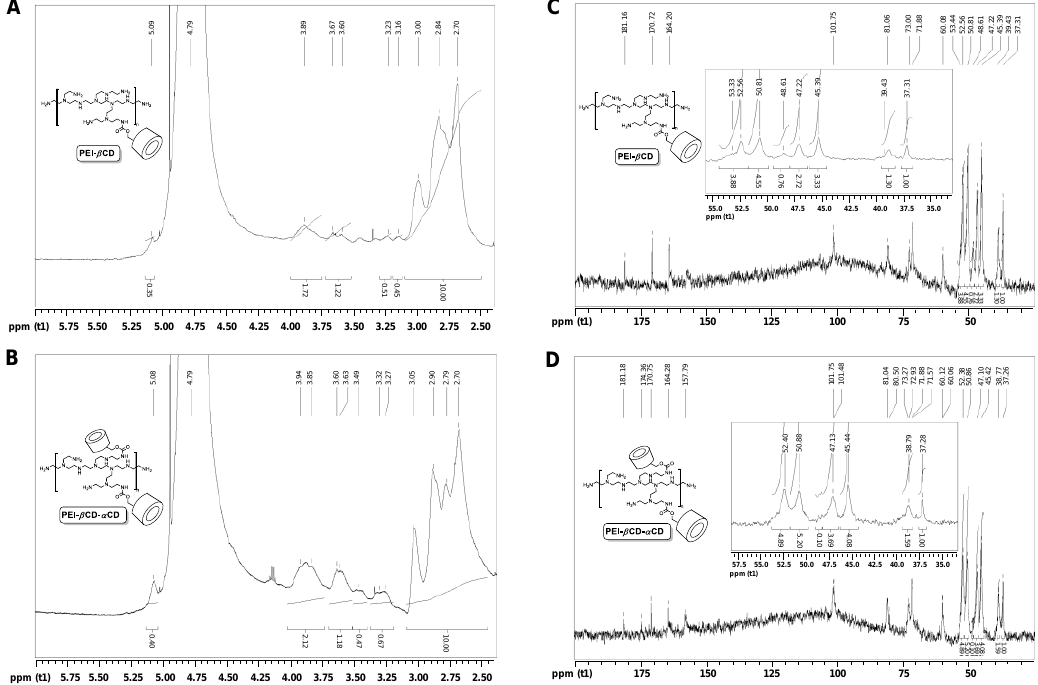
Figure 1. 1 H NMR spectrum (500 MHz, D 2 O) of PEI- β CD ( A ) and PEI- β CD- α CD ( B ). Inverse-gated 13 C H NMR spectrum (125 MHz, D 2 O) of PEI- β CD ( C ). The ratio of PEI’s amino groups (NH 2 :NH:N) is 1.00:1.48:1.22, which stands for 6% of functionalization of primary amino groups of PEI with β CD. Inverse-gated 13 C H NMR spectrum (125 MHz, D 2 O) of PEI- β CD- α CD ( D ). The ratio of PEI’s amino